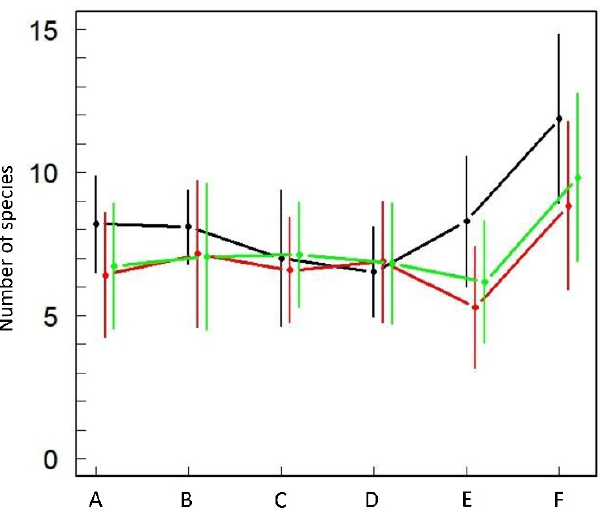
Figure A5. Before/after change in species richness observed in six vegetation classes belonging to a grassland-to-woodland gradient (A to F), in unburned surveys (black curve) and burned surveys the first year (red) and the eighth year (green) after a fire.